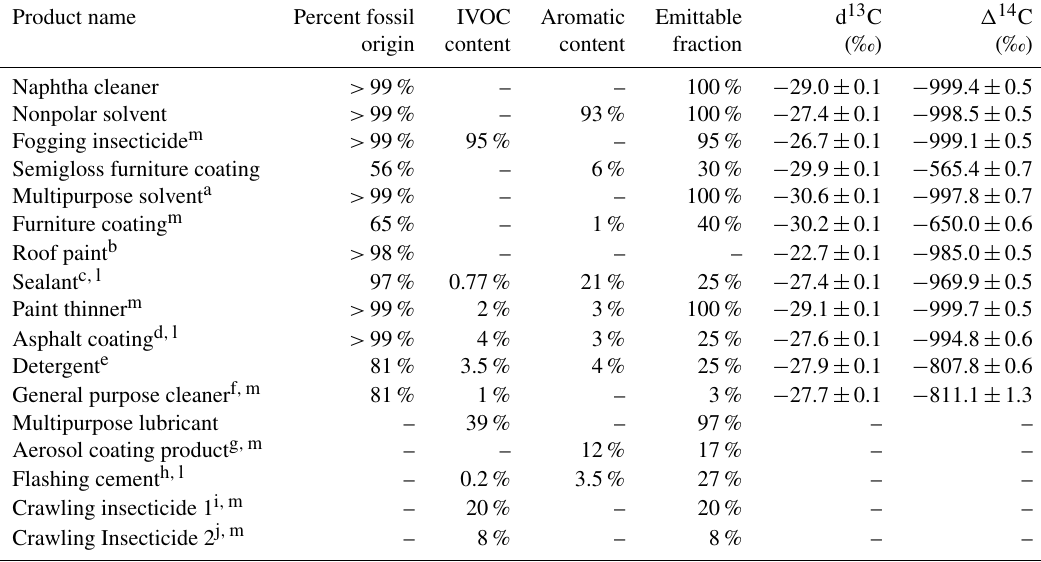
Table 1. Composition and emittable fraction of 12 commercially available consumer products and the results of their carbon isotope analysis. Please see Table S1 for detailed mass distribution profiles and Table S7 for detailed carbon isotopic analysis results k